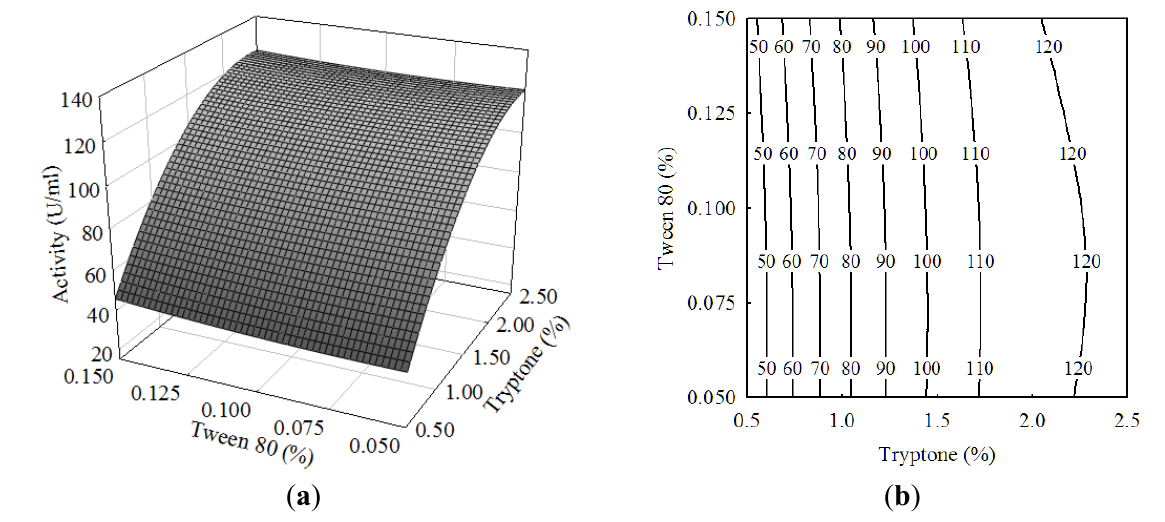
Figure 3. ( a ) Response surface curve and ( b ) contour plot showing the effect of tryptone and Tween-80 on the lipase activity of Burkholderia sp.